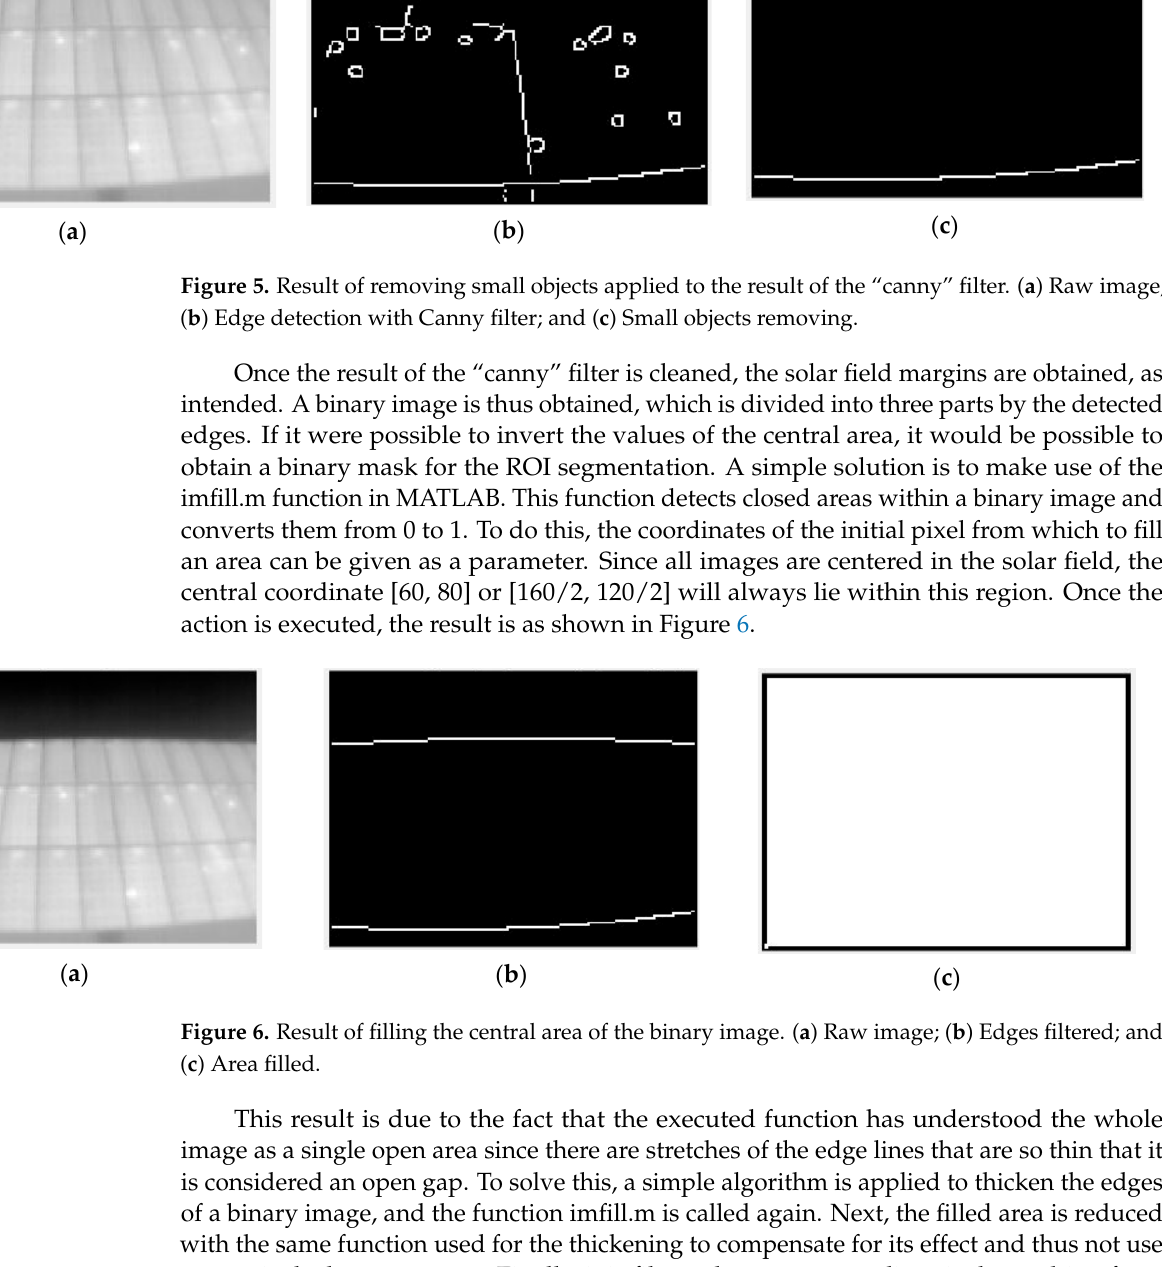
Figure 6. Result of filling the central area of the binary image. ( a ) Raw image; ( b ) Edges filtered; and ( c ) Area filled.